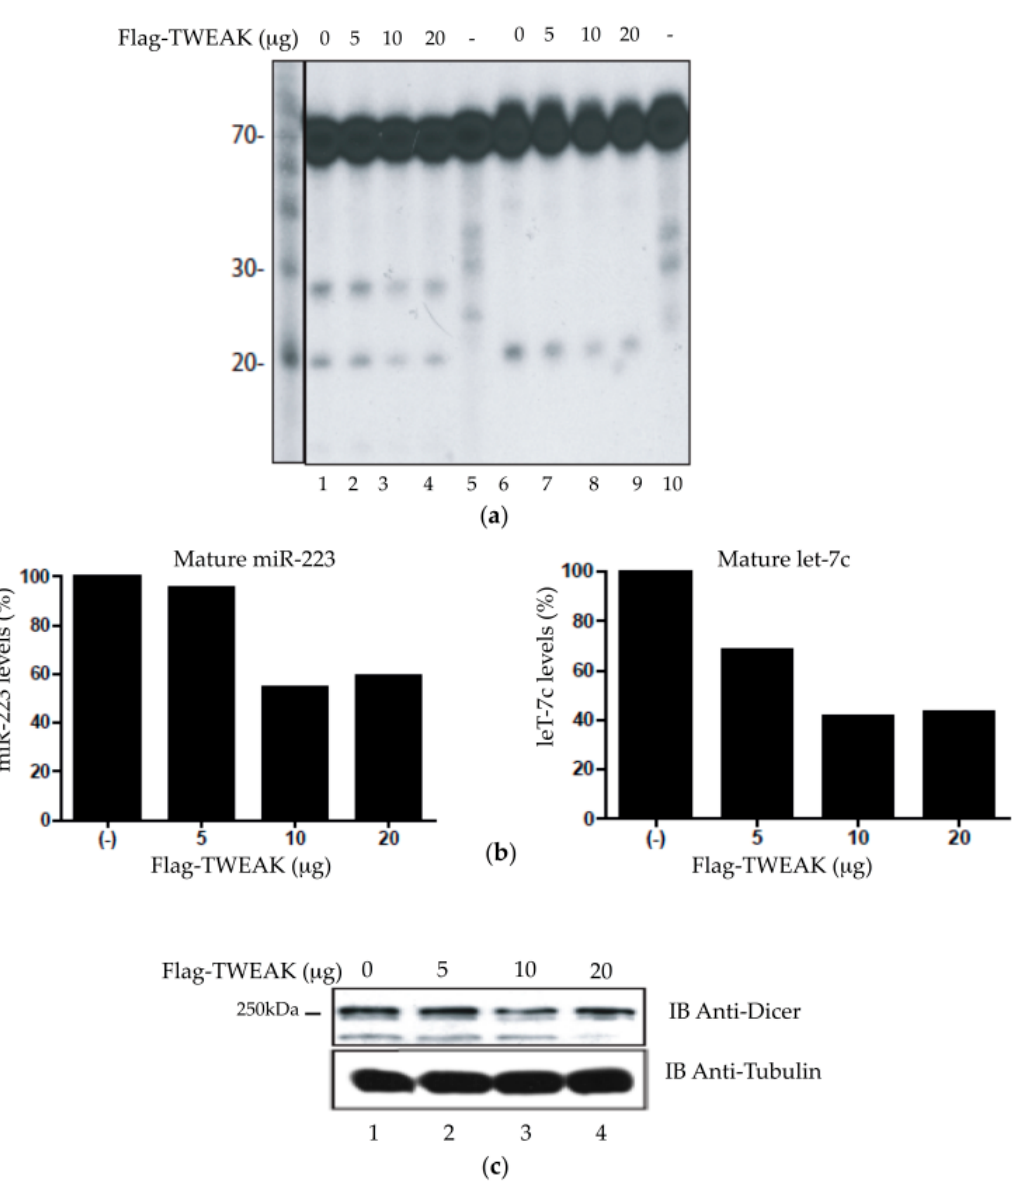
Figure 4. TWEAK dose ‐ dependently reduces pre ‐ microRNA conversion into mature microRNA by Dicer. ( a , b ) Cleared lysates (50 μ g of proteins) prepared from HEK 293 cells, transfected with increasing amounts of pcDNA3.1 ‐ Flag ‐ TWEAK vector (0–20 μ g of DNA), were incubated with 5 ′ 32 P ‐ labeled human pre ‐ miR ‐ 223 (miRBase acc. no. MI0000300) or pre ‐ let ‐ 7c (miRBase acc. no. MI0018703). ( a ) The 32 P ‐ labeled pre ‐ microRNA substrates and cleavage products of Dicer were revealed by denaturing polyacrylamide gel electrophoresis (PAGE)/autoradiography; ( b ) The ≈ 20 ‐ nt bands corresponding to the mature microRNA products were analyzed by densitometry using the ImageJ ® software; ( c ) The Dicer protein level in the HEK 293 cell lysates was analyzed by immunoblotting using anti ‐ Dicer antibody, with anti ‐ tubulin as a reference. 2.5. TWEAK Impairs MicroRNA ‐ Guided RNA Silencing of a Reporter Gene Induced by a Pre ‐ MicroRNA The ex vivo microRNA ‐ modulatory effects of TWEAK were corroborated in transiently